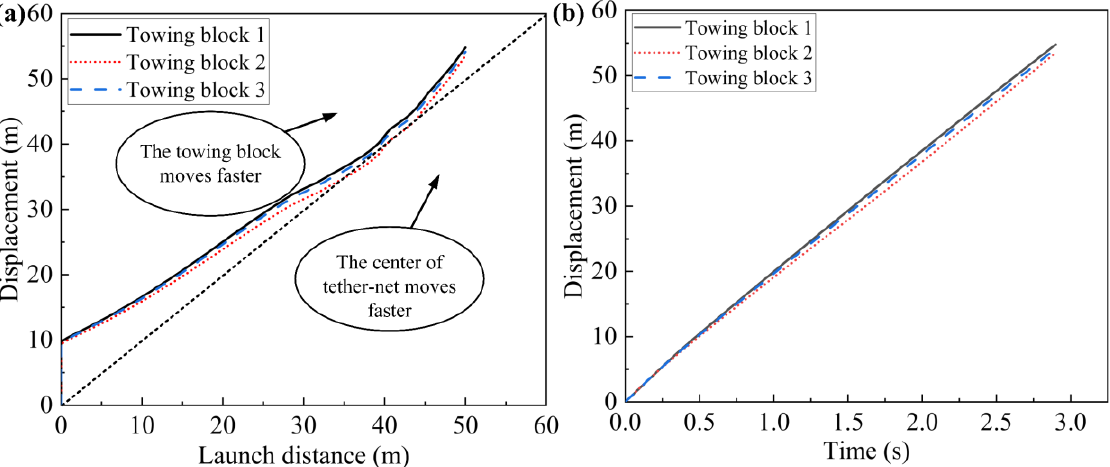
Figure 16. Displacement of different towing blocks. ( a ) Displacement – launch distance. ( b ) Displacement – time.